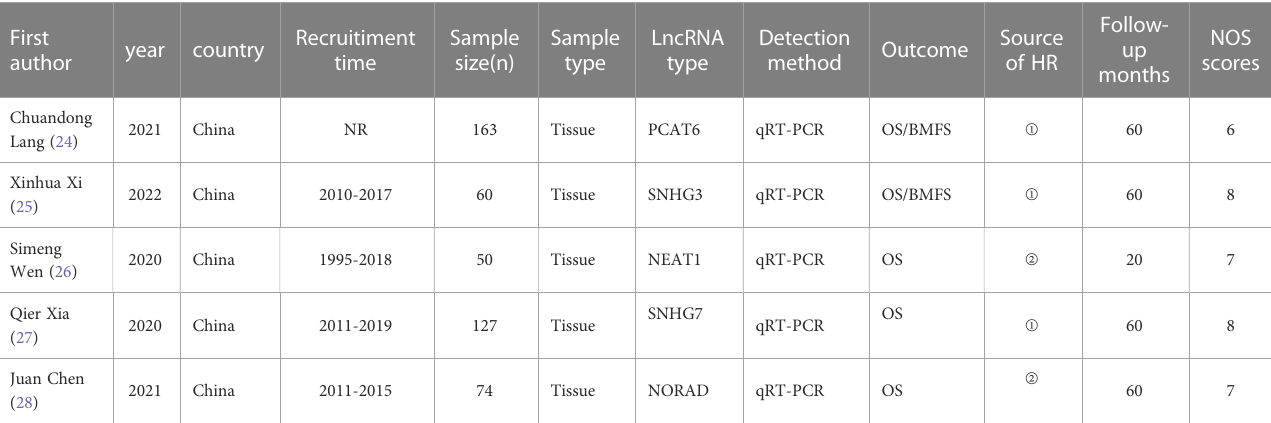
TABLE 2 Main characteristics of all eligible studies included in the meta-analysis.